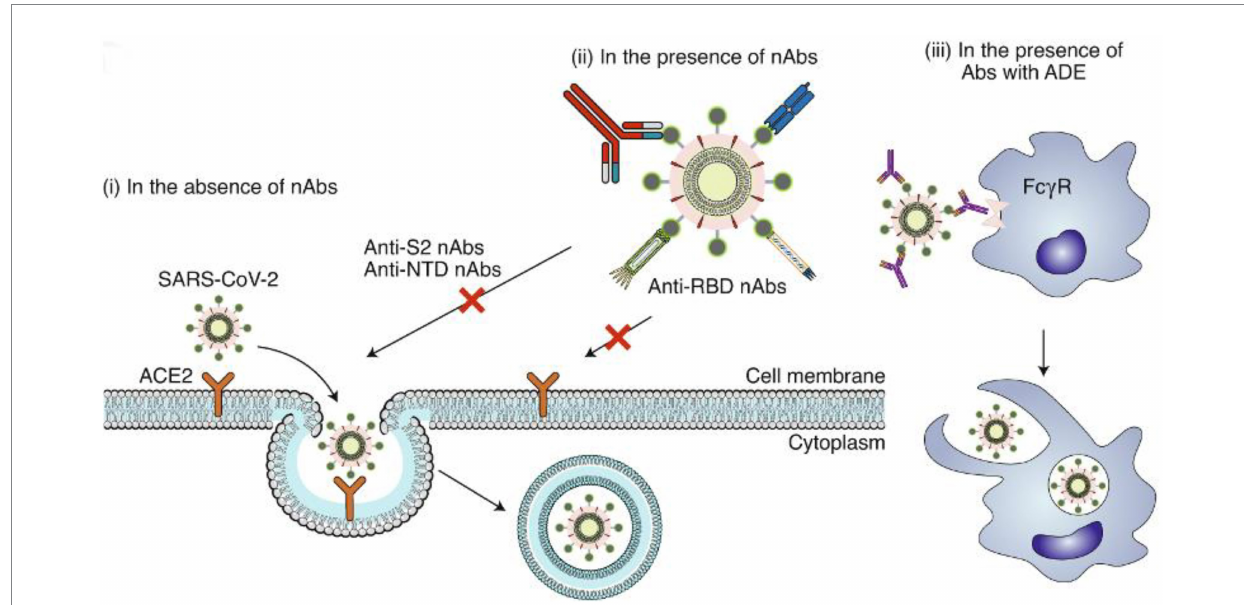
FIGURE 1 Potential mechanisms of action in SARS-CoV-2 neutralizing antibodies. (i) In the absence of nAbs, SARS-CoV-2 binds to the viral ACE2 receptor via the RBD, mediating viral entry into target cells. (ii) In the presence of RBD-specific nAbs, the antibodies bind to the RBD and inhibit RBD binding to ACE2, resulting in the inhibition of membrane fusion and the entry of the virus into the host cell. Some non-RBD-targeting nAbs may bind to the NTD, the S trimer or the S2 subunit (thus preventing conformational changes of S or inhibiting membrane fusion and viral entry). (iii) In the presence of nAbs with suboptimal or negligible neutralizing activity, the antibody-bound virions may enter cells (such as monocytes or macrophages) through the Fc γ R, leading to enhanced viral entry, viral replication or inflammation. Image and description courtesy of Jiang et al.